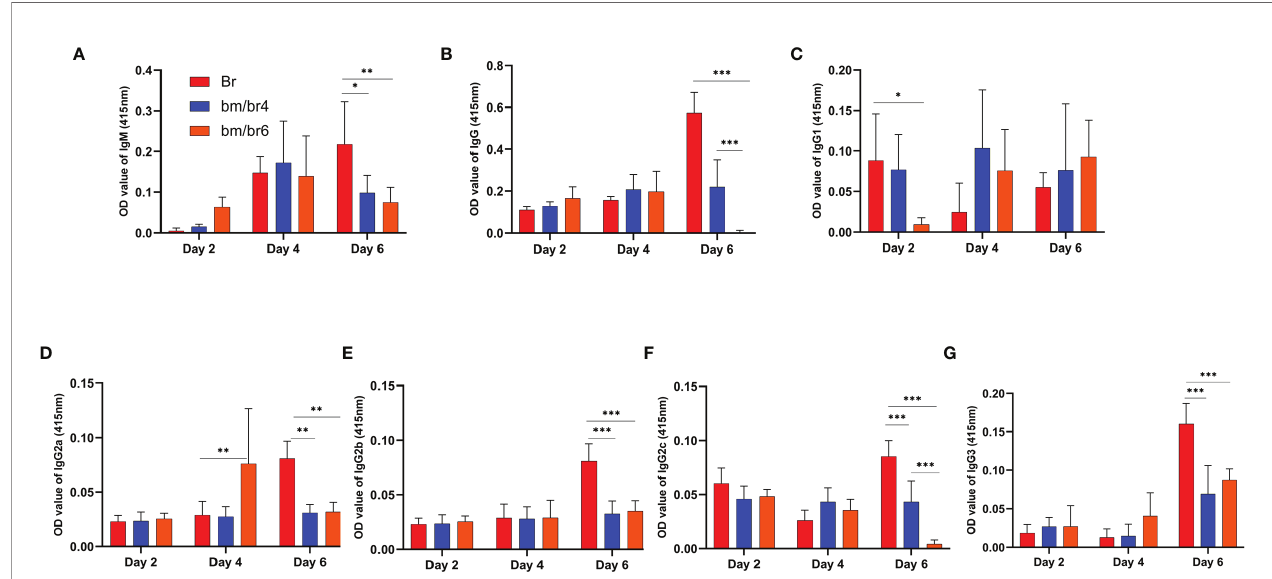
FIGURE 5 | Kinetics of serum antibodies speci fi c to B. rodhaini after challenge infection. The production of (A) IgM, (B) IgG, (C) IgG1, (D) IgG2a, (E) IgG2b, (F) IgG2c, and (G) IgG3 in mice after challenge infection with B. rodhaini was determined in Br mice and B. rodhaini and B. microti co-infected groups (bm/br4 and bm/br6 mice). Detection of IgGs and IgM was performed on days 2, 4, and 6. For the detection of serum antibodies against B . rodhaini , rBrP26 protein was used as the detection antigen in ELISA assays. The results are expressed as mean values ± the SD for six mice. Ordinary one-way analysis of variance (ANOVA) with Tukey ’ s